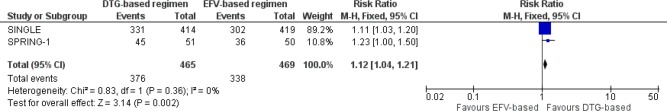
DTG + two NRTI vs. EFV + two NRTIs.Viral suppression to non-detectable (<50 copies/mL) at 96 weeks.